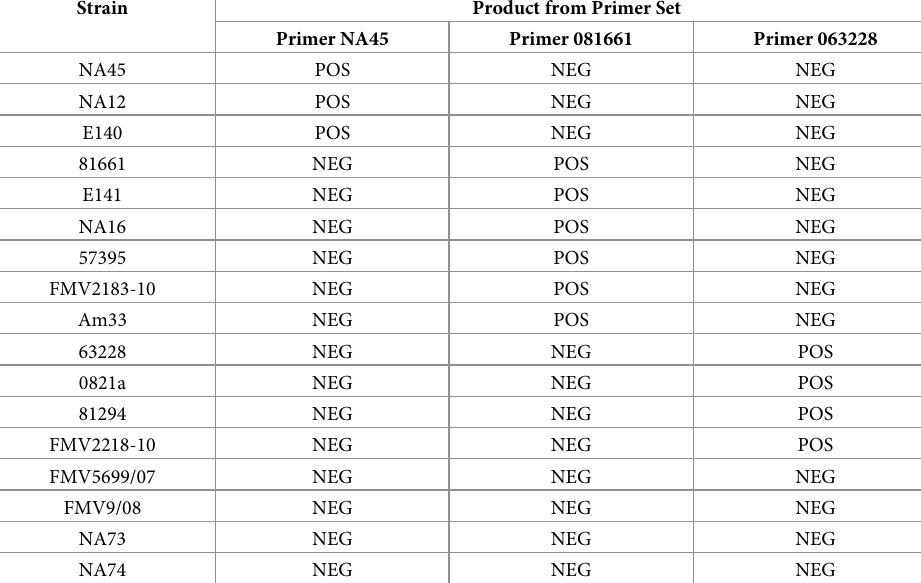
Table 3. Amplification of the sbi gene from three different primer sets.